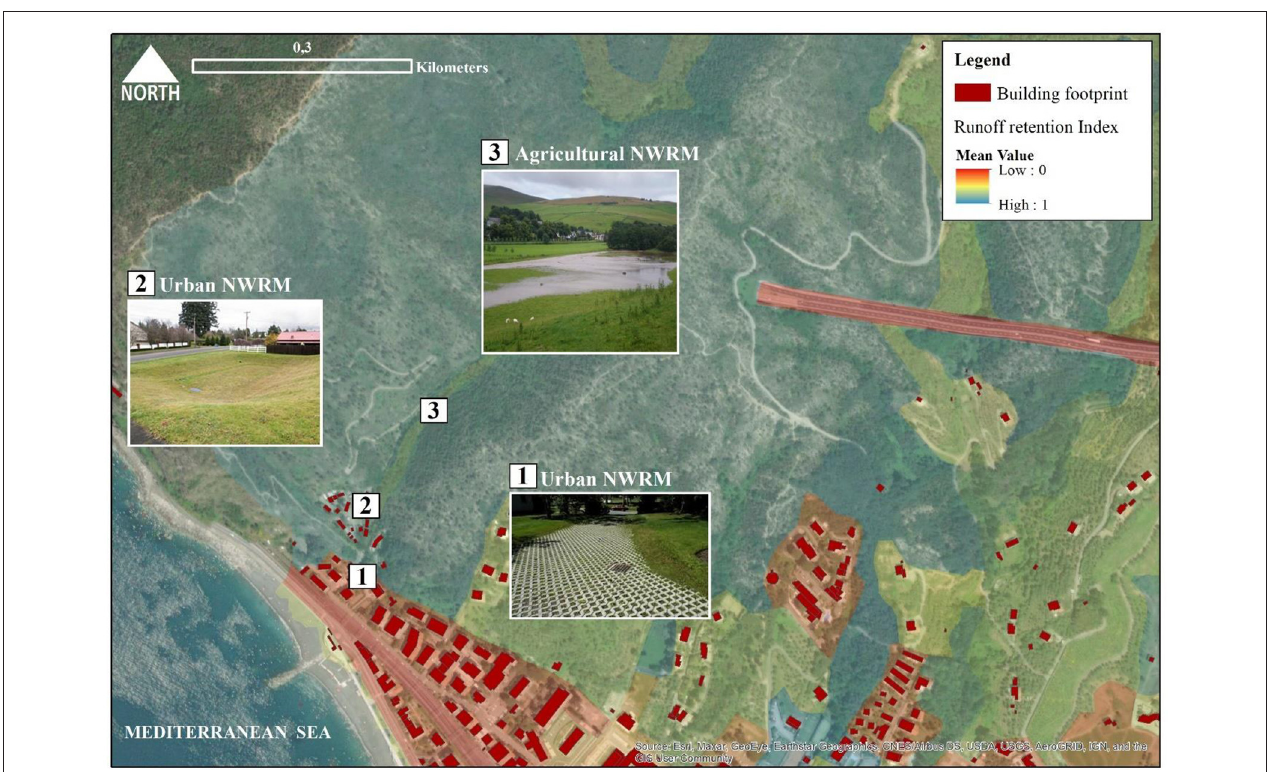
FIGURE 8 | NWRM for watershed N of “Ambito 17” in Sestri Levante (source: authors).